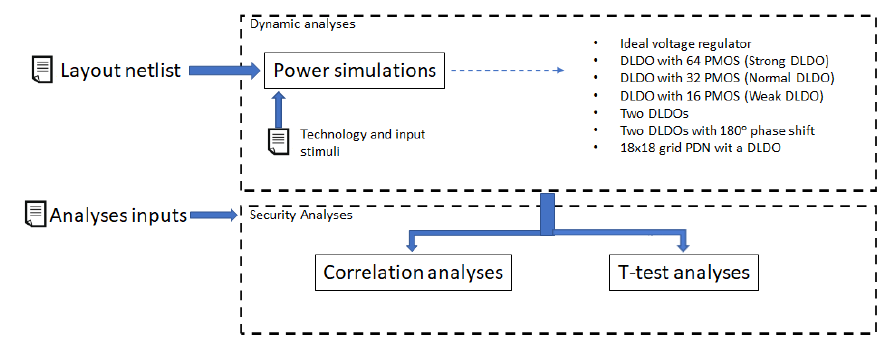
Figure 8. Flowchart of the procedure of experiments and security analyses.